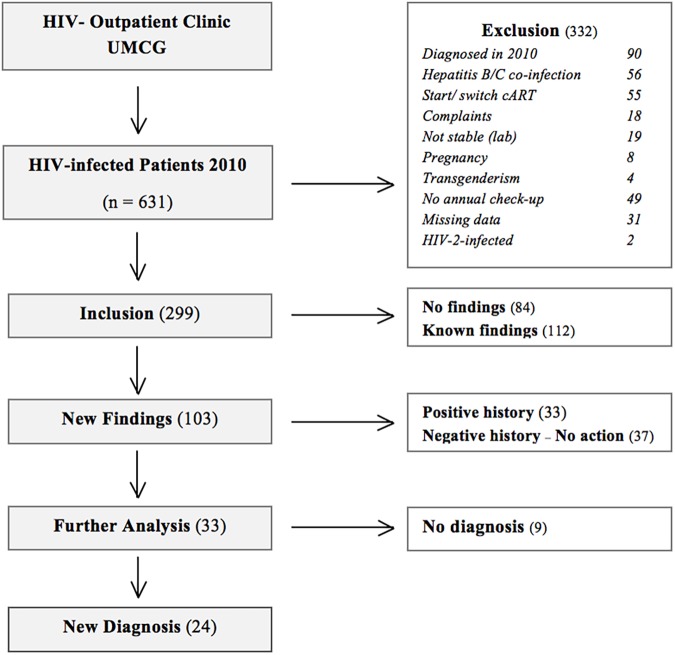
Flowchart patient selection.